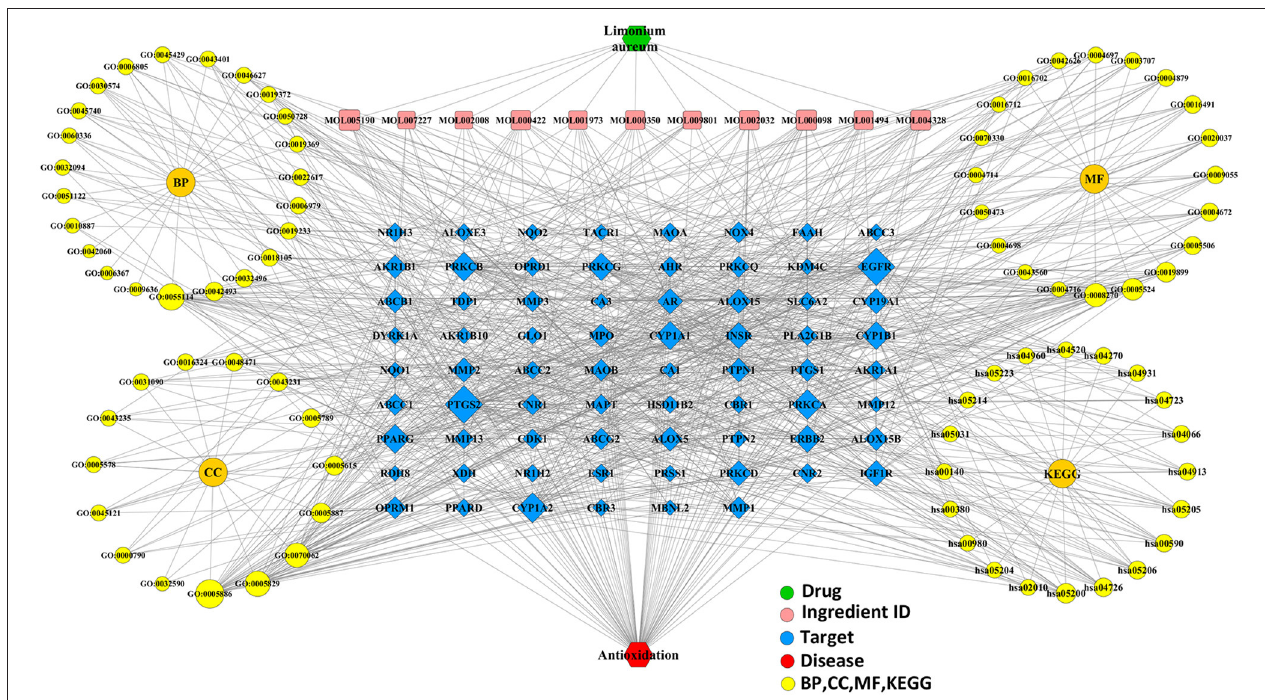
FIGURE 8 | The integrated visualization network based on the network pharmacology findings.